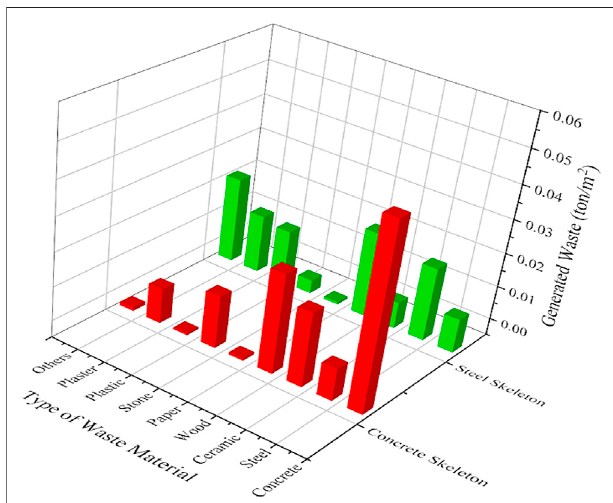
FIGURE 8 | Penalty estimation (A) Produced waste (tons) (B) Penalty/cost of project (%).